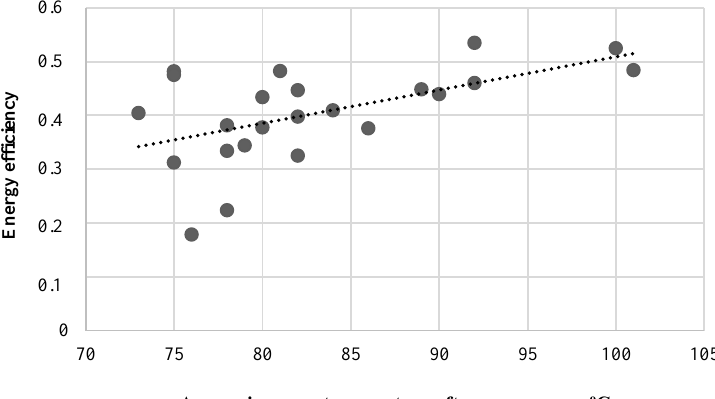
Fig. 6. Two-stage compressor refrigeration system exergy efficiency depending on ammonia vapor temperature after